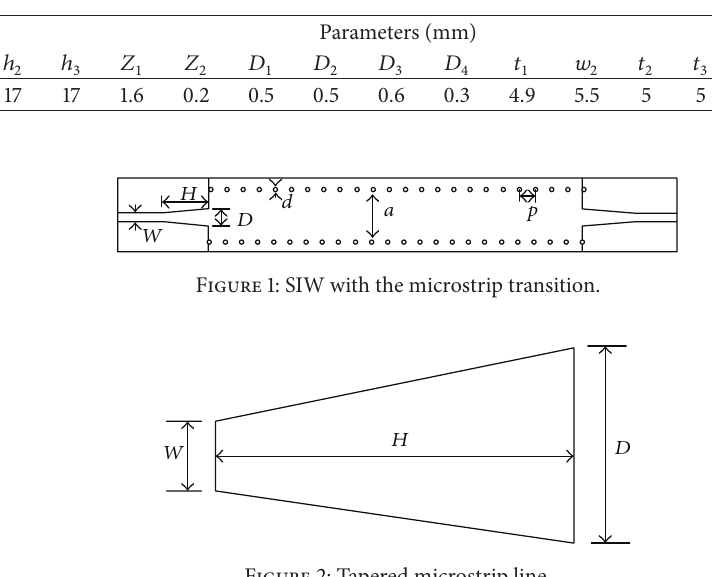
Figure 2: Tapered microstrip line.